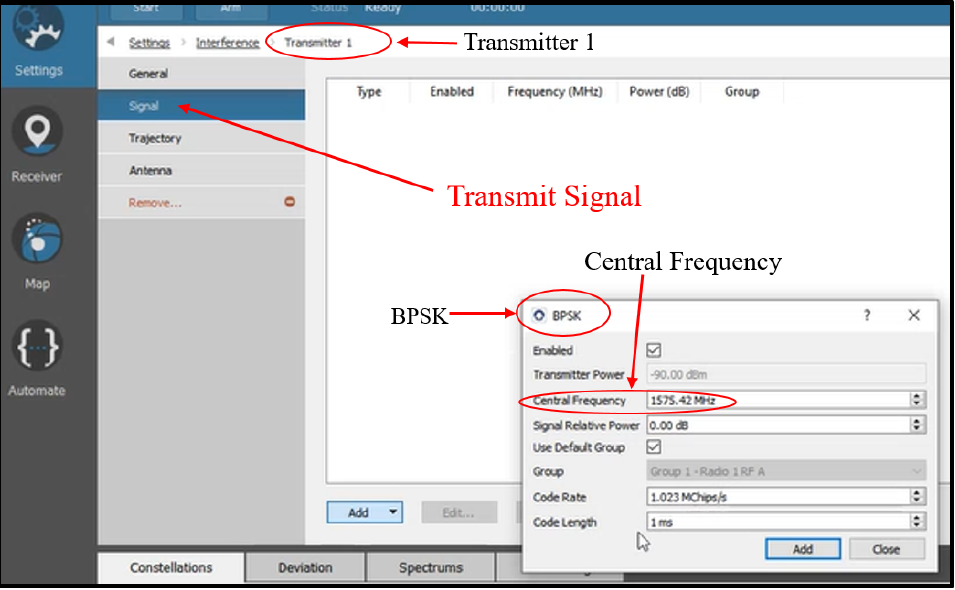
Figure 4. Creating central frequency of BPSK